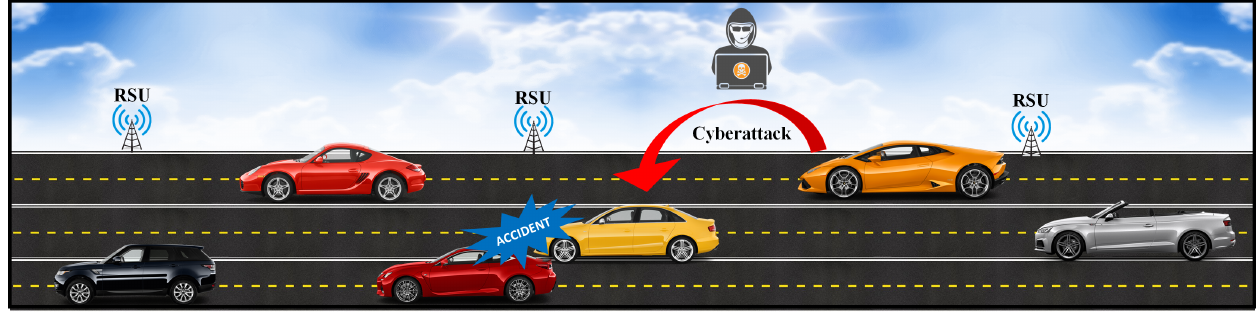
Figure 1. A cyber attack scenario in smart